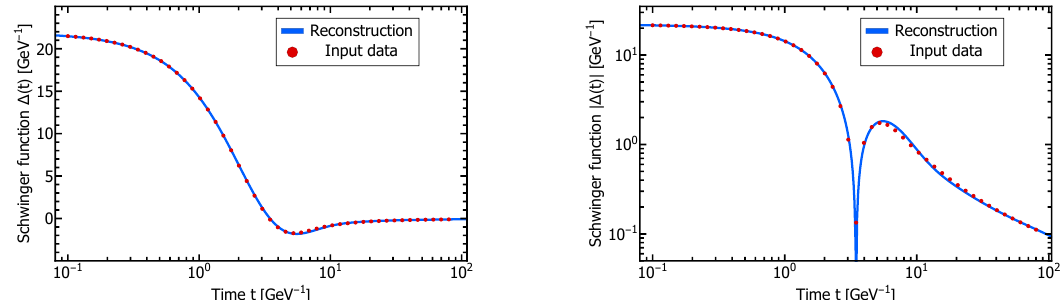
Figure 8: Schwinger function obtained from the reconstruction, blue line, and from the Euclidean input, red dots, in a semi-log (left) and log-log (right) depiction. See Figure 6 for the corresponding Euclidean propagators in momentum